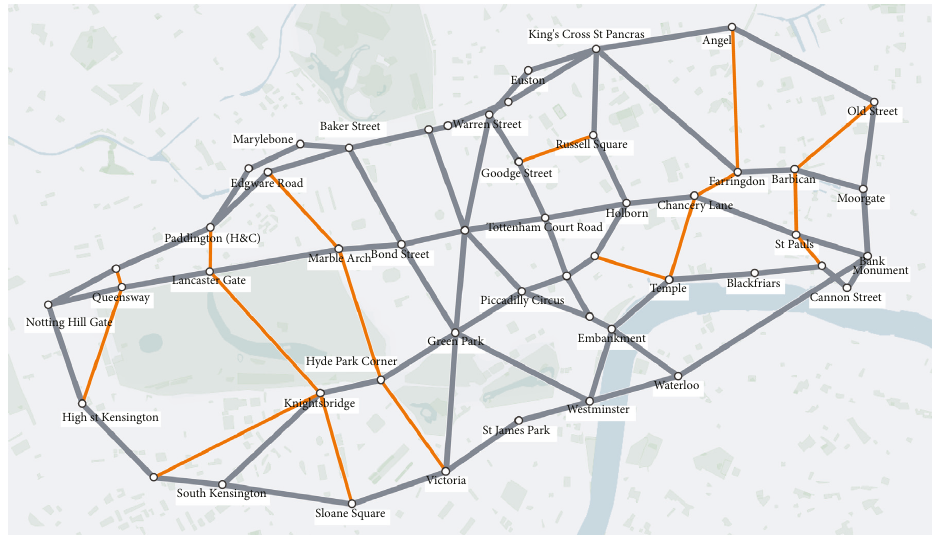
Figure 7: Central London Tube network.